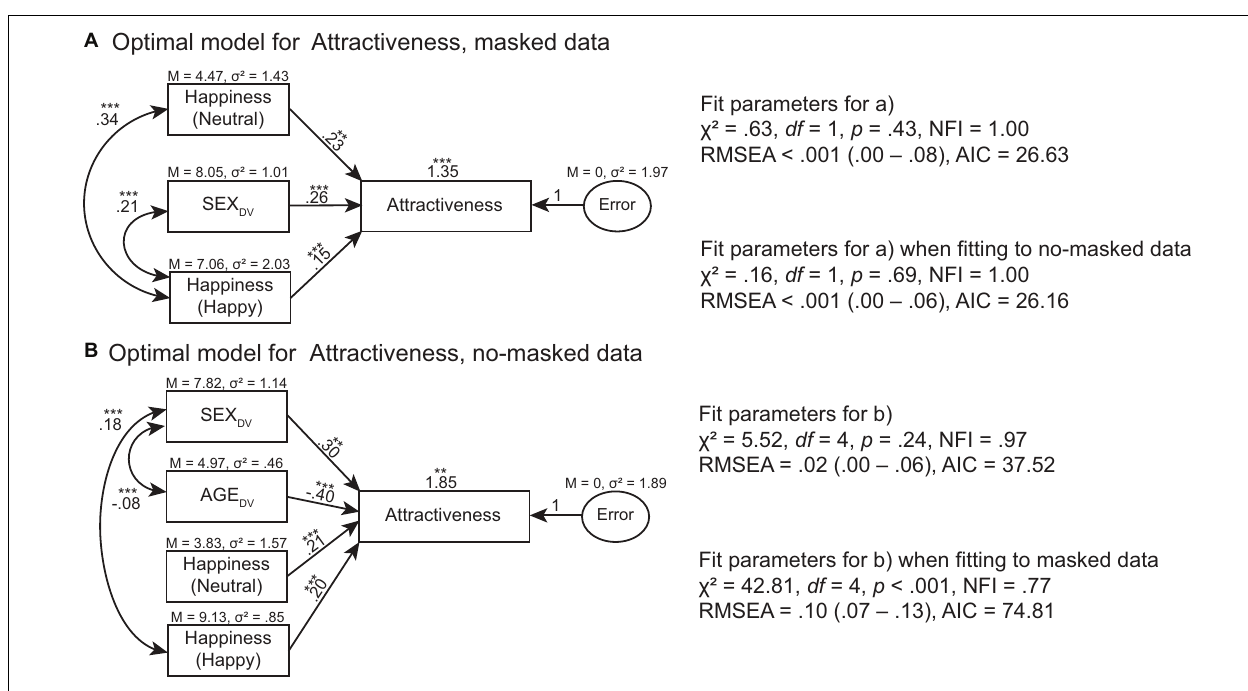
region was a critical facial feature for communicating happiness (Beaudry et al., 2014). When crucial information from the mouth was blocked by the face masks, the ability to recognize happiness